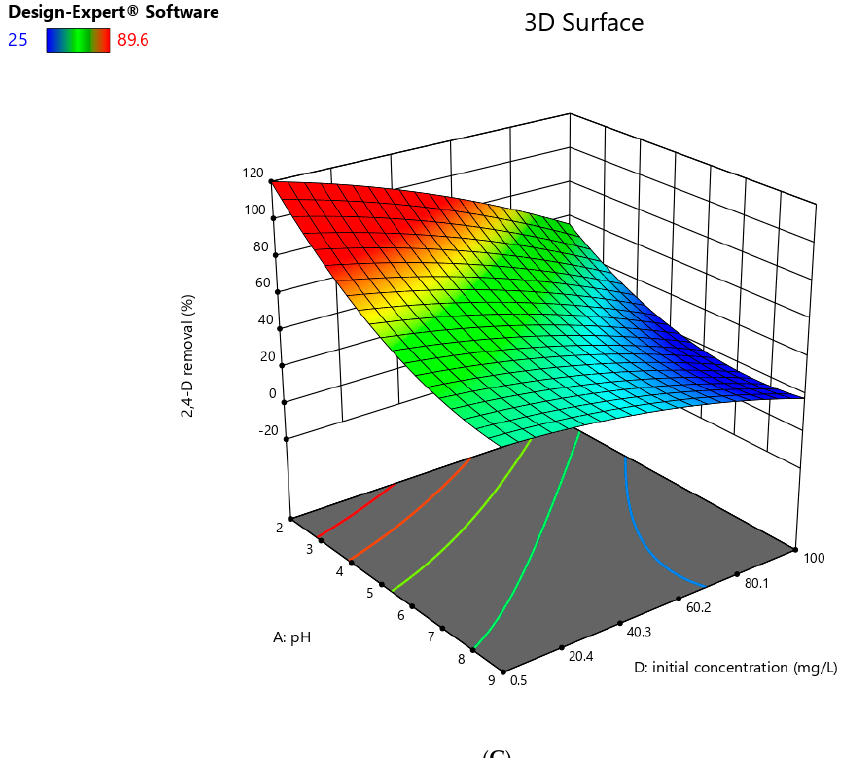
Figure 13. The interaction between ( A ) contact time and pH. ( B ) adsorbent dose and pH, and ( C ) initial concentration and pH, illustrating their effect on 2,4-D adsorption.